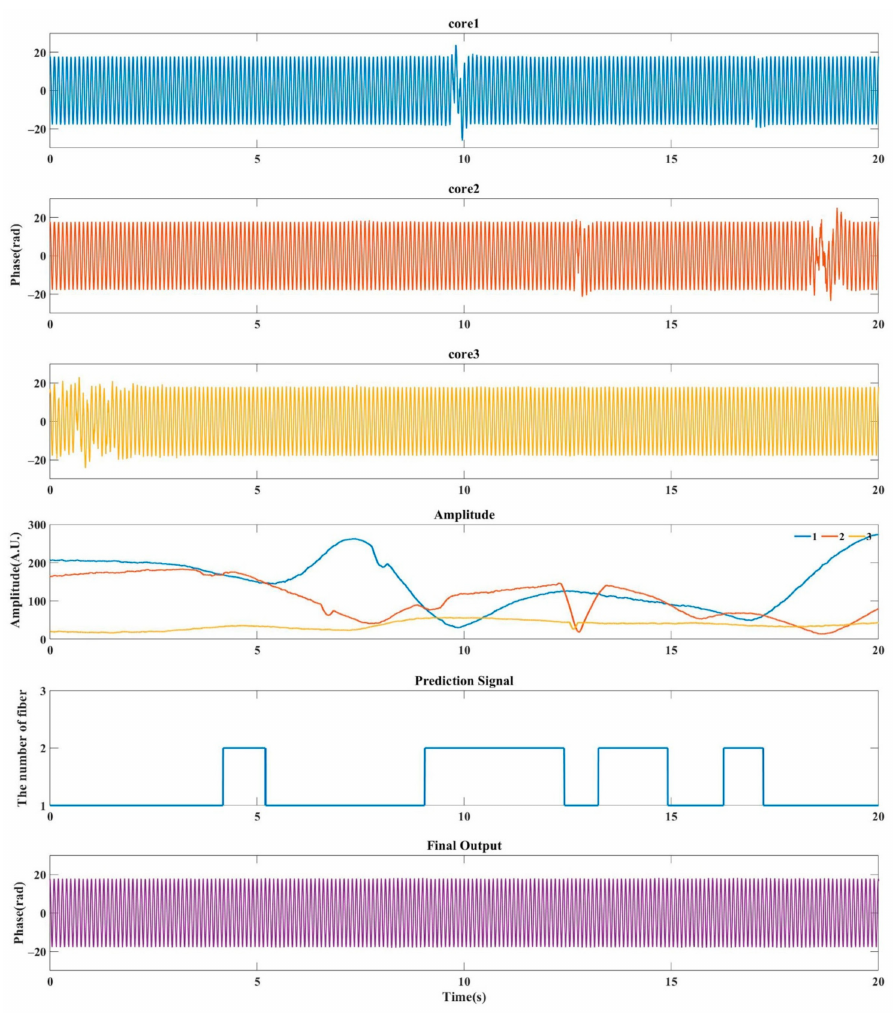
Figure 8. Extracted phase signal from all single beat frequency, as well as prediction signal and final output (selection based on signal amplitude).